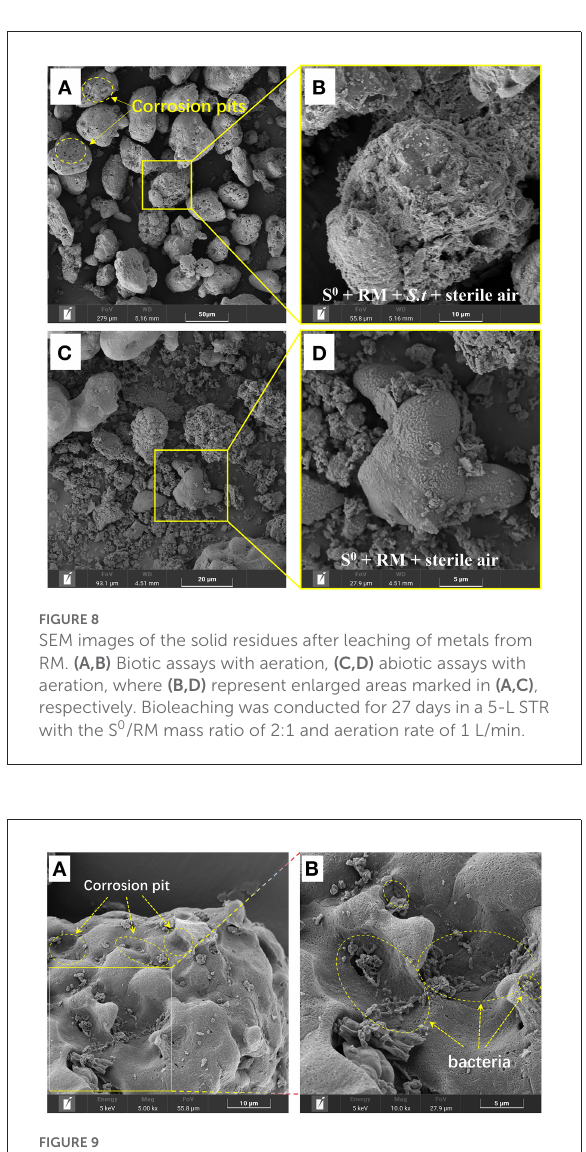
those in the biotic assay without air supply and abiotic assays (Figure 7D). In the biotic assay with the aeration rate of 1 L/min, the extraction rates of Ce and Y increased rapidly from day 8 to 20 and reached a maximum on day 24, followed by a slight decrease (Supplementary Figure S4). The decrease in the extraction rate of Ca on day 22 could be attributed to the formation of gypsum. On the other hand, the extraction rate of Ti increased (reaching 18%) compared to the flask bioleaching experiment, which can be ascribed to an increased rate of dissolution of Ti-bearing phases in RM due to a higher concentration of H + generated from more efficient S 0 bio-oxidation (Agatzini-Leonardou et al.,